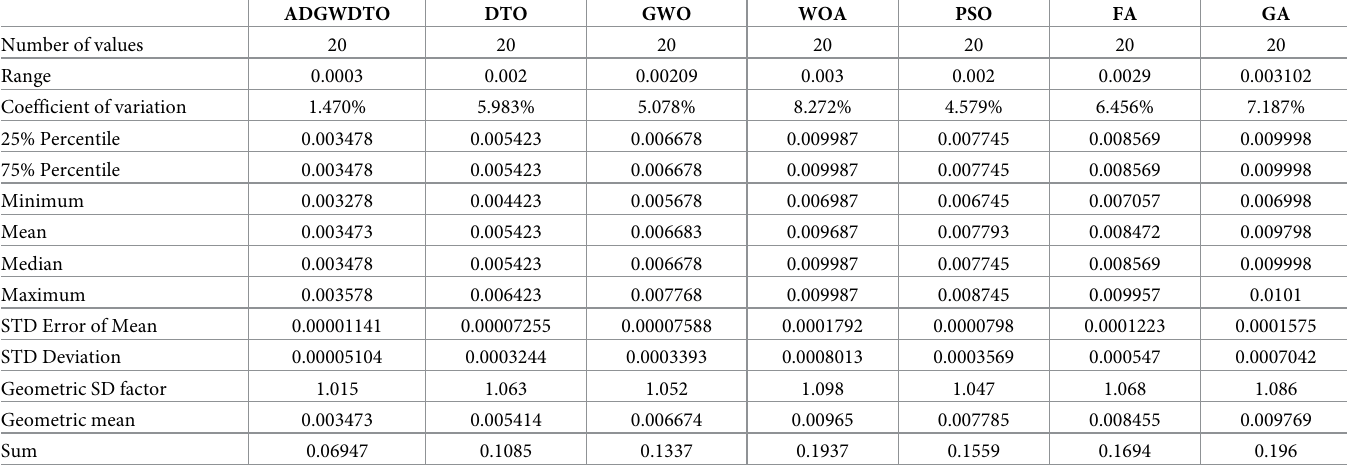
Table 8. Analysis of the results achieved by the proposed ensemble model compared to state-of-the-art algorithms.